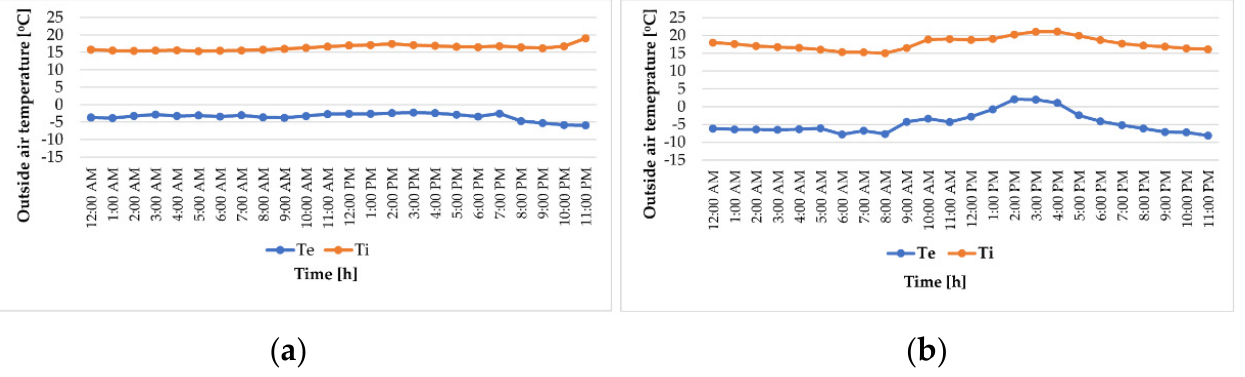
Figure 10. Correlation between the hourly variation of the outdoor temperature and the hourly var- iation of the indoor temperature, in the room adjacent to the experimental model, on 29 January 2014 ( a ) and on 30 January ( b ).